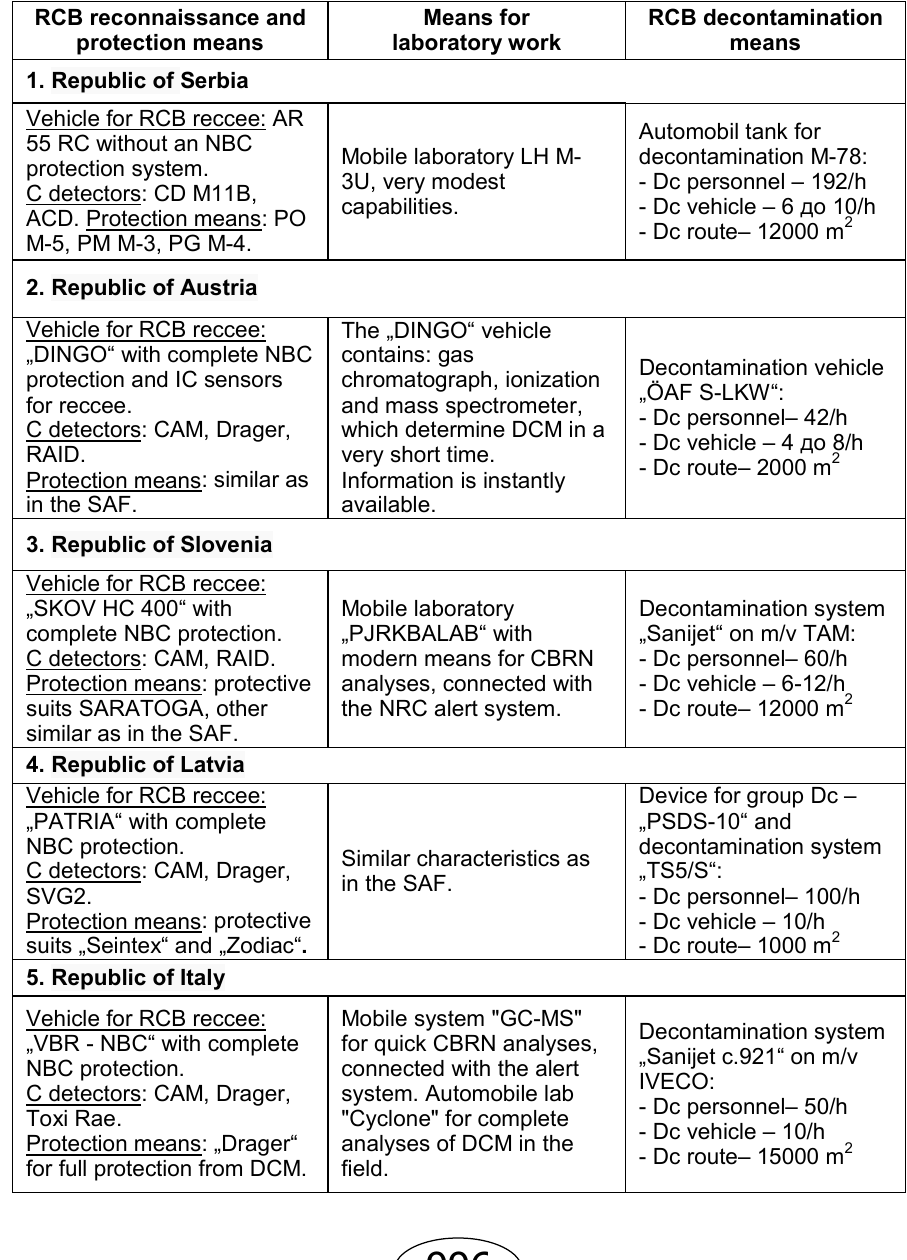
Table 3 – Comparative display of the CBRN service units of the armed forces of foreign countries and those of the SAF Таблица 3 – Сравнительный обзор отечественных и иностранных взводов РХБЗ Tabela 3 – Uporedni prikaz jedinica ABH službe VS i stranih zemalja RCB reconnaissance